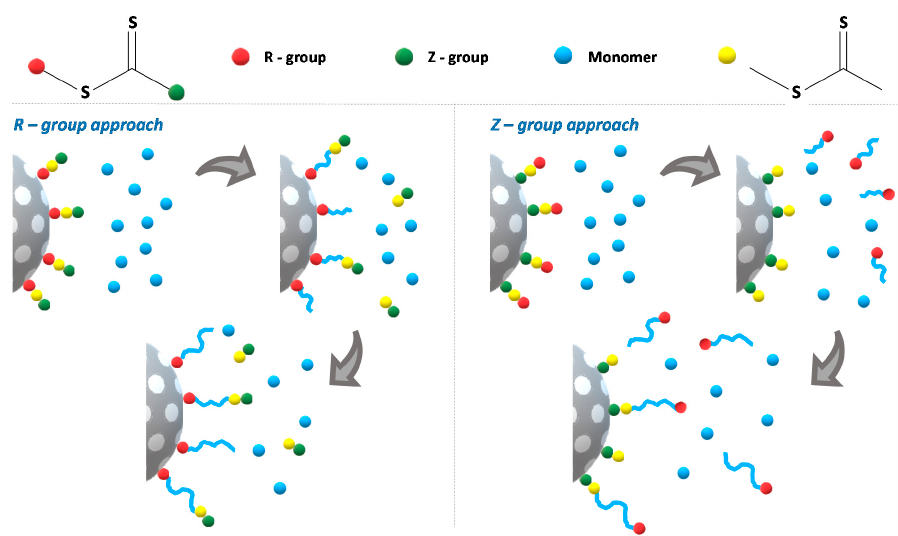
Figure 4. Strategies for surface-initiated RAFT polymerization (gRAFT-from) using a dithioester CTA (equivalent for a trithiocarbonate CTA). In the R-group approach, the RAFT is immobilized by the R group and the grafted polymer chains grow from the surface with the propagating radicals easily accessible on the terminal end for the chain-transfer reactions. In the Z-group approach, the RAFT